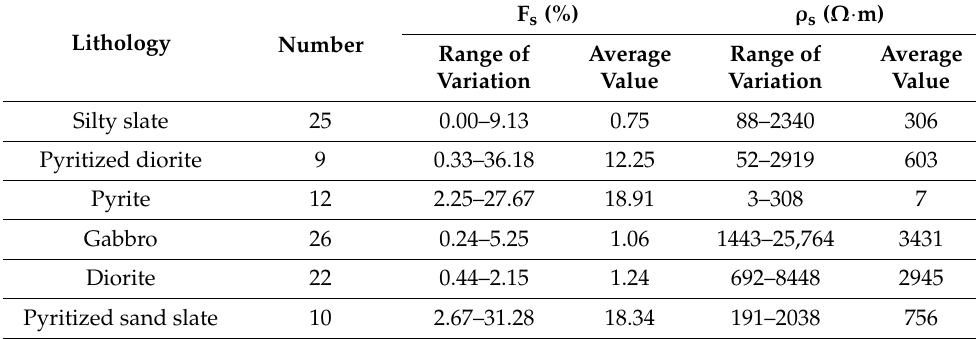
Table 1. Electrical parameters of rock (ore)